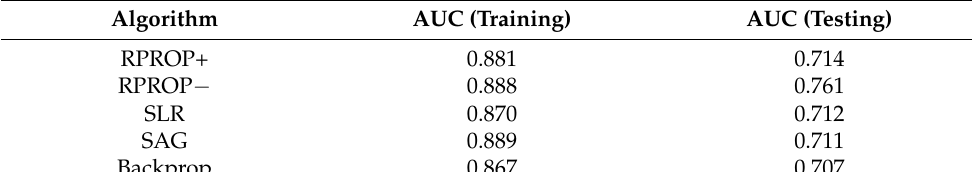
Table 7. ROC AUC values for training and test datasets.